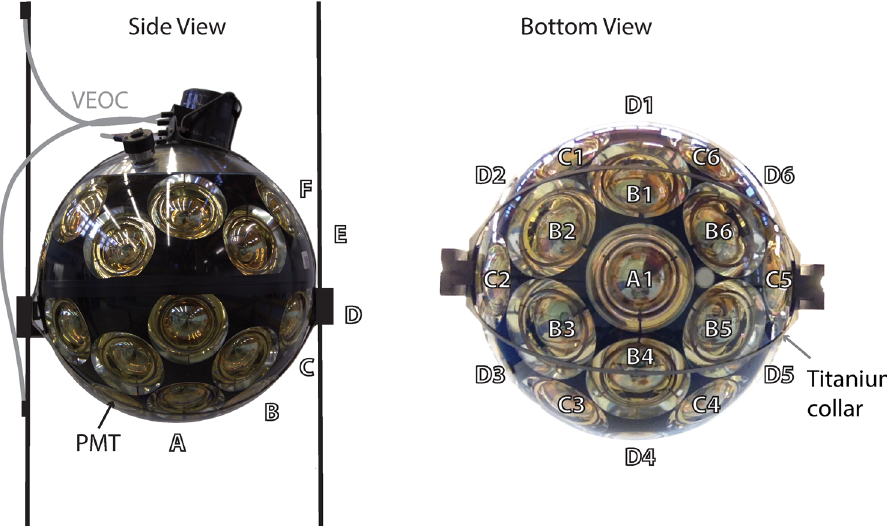
Fig. 1 Side view (left) and bottom view (right) of a KM3NeT DOM. See text for explanation of highlighted (mechanical) parts. The naming convention of the PMTs in rings and numbers is